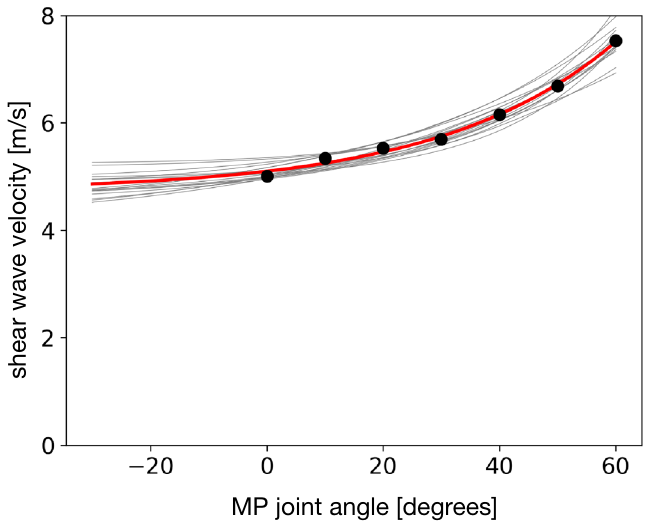
Figure 8. Exponential curve (red curve) fitted to the group mean SWV plots (black plots) against the different MP joint dorsiflexion angles and the exponential curves of the 20 individual participants (gray curves).